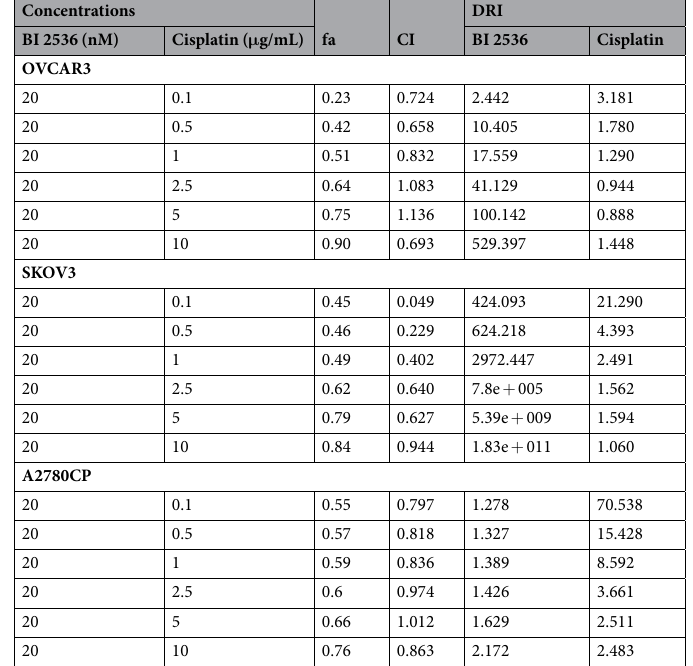
Table 2. Combination index (CI) and dose reduction index (DRI) of BI 2536 and cisplatin combination in OVCAR3, SKOV3 and A2780CP cells. DRI represents the order of magnitude of dose reduction that is allowed in combination for a given degree of effect as compared with the dose of each drug alone. “fa” denotes fraction affected.